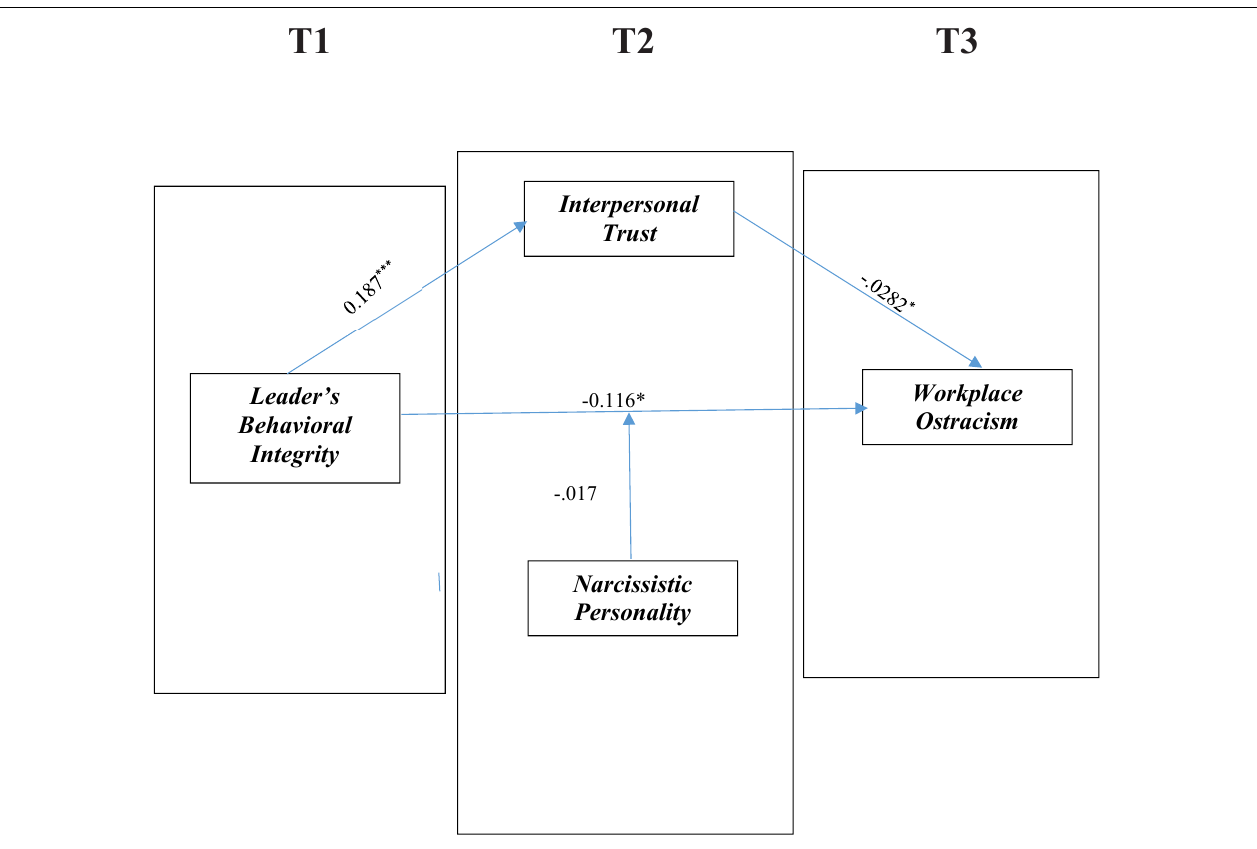
FIGURE 2 | Summary of the findings. T1, time lag 1; T2, time lag 2; T3, time lag 3; ∗ p < 0.10, ∗∗∗ p < 0.01.